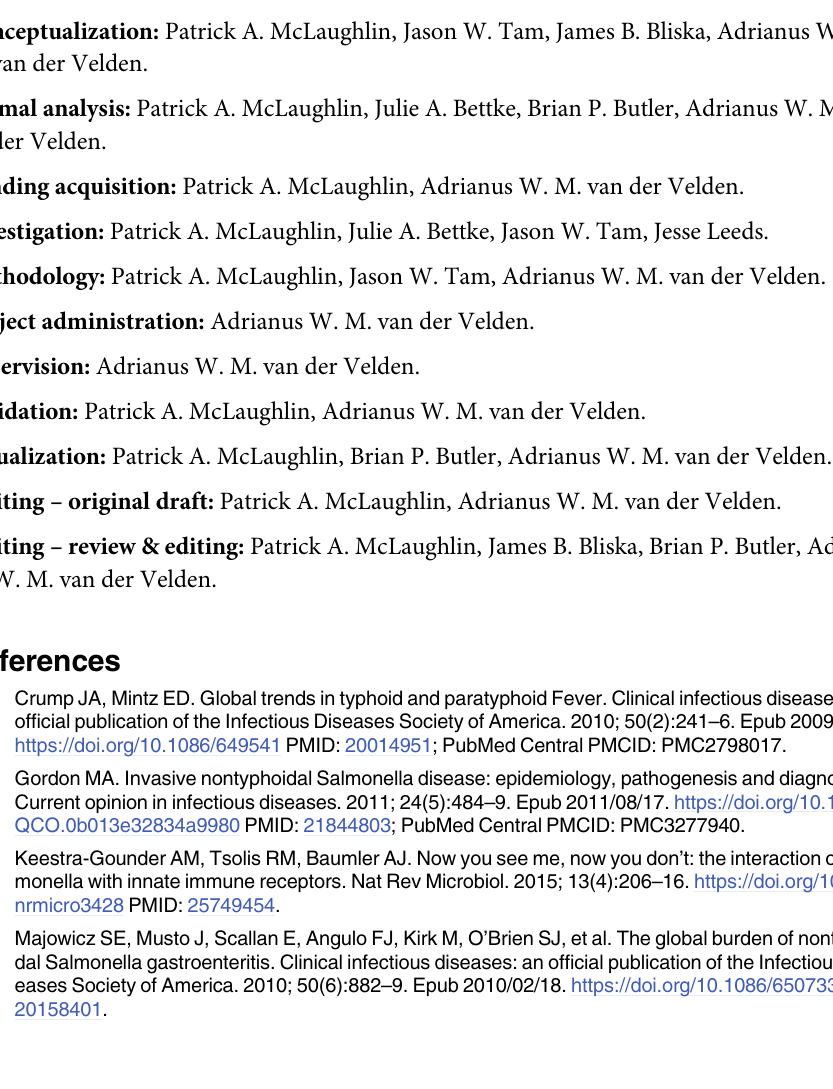
S1 Table. Oligonucleotides. Oligonucleotides used in this study for PCR ( Salmonella patho- genesis) or quantitative PCR (transcript